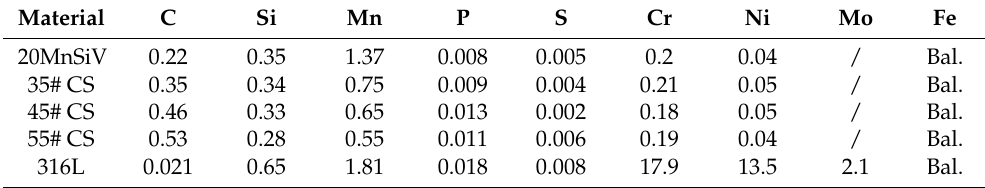
Table 1. Chemical compositions of 20MnSiV and 316L stainless steel. (wt. %).